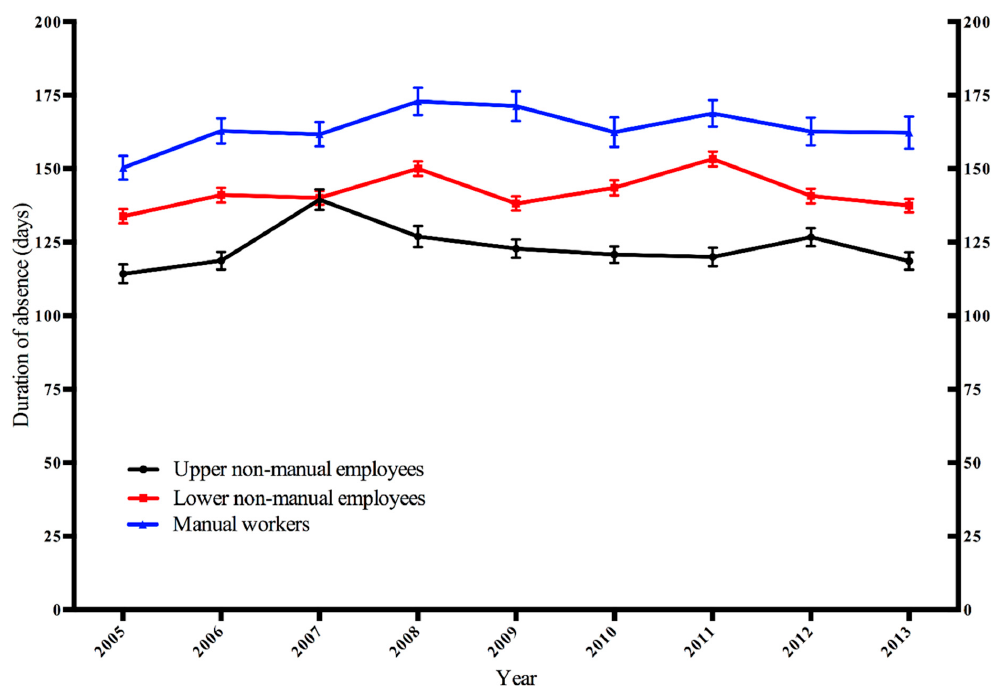
Figure 2. Age-adjusted annual duration of sickness absence due to breast cancer by occupational class among Finnish women aged 35–64